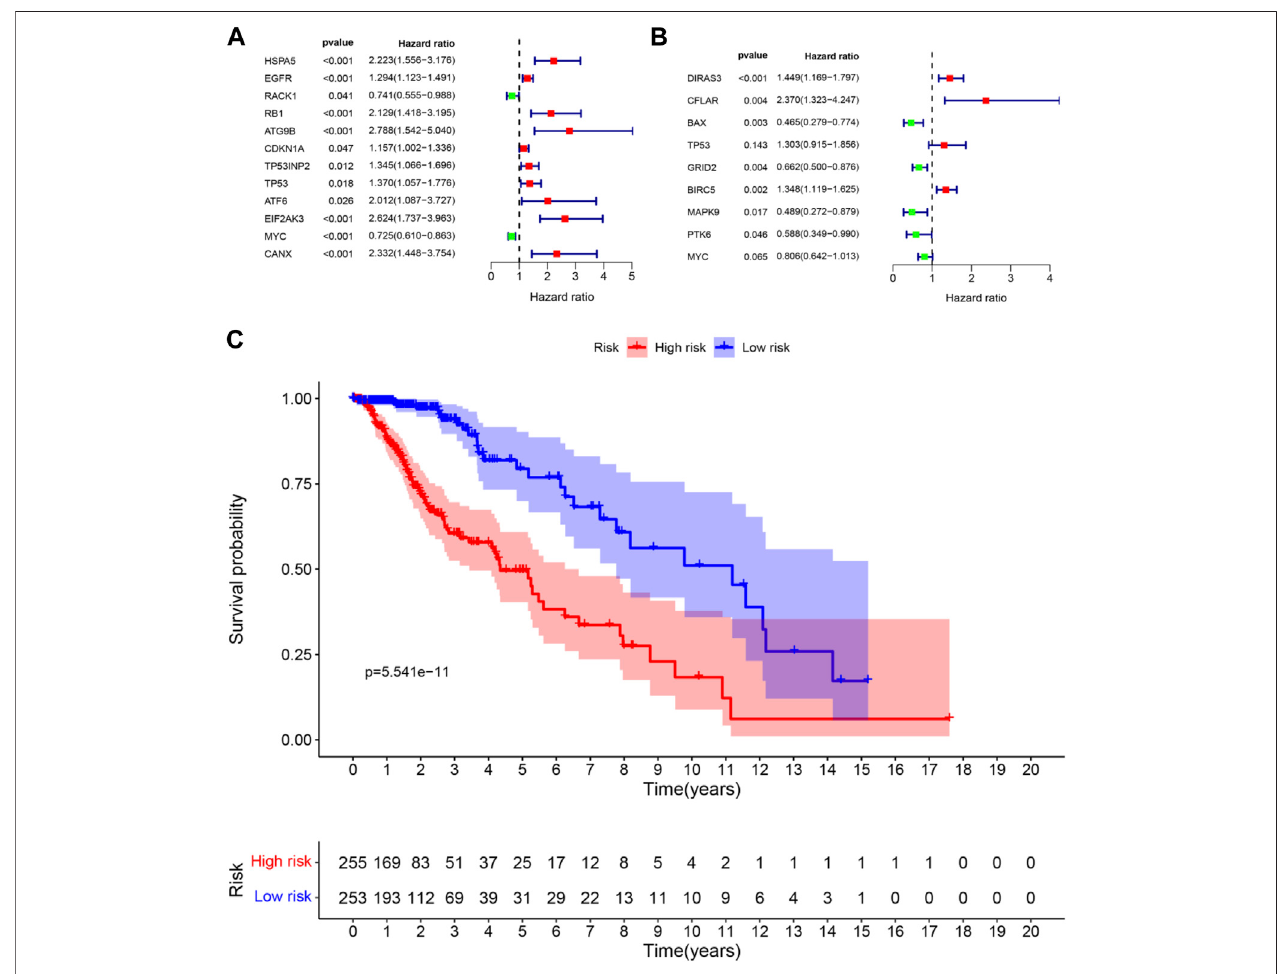
FIGURE 3 | Forest plots and Kaplan – Meier curve (A) forest plot of univariate Cox regression for 12 prognosis-related DE-ARGs; (B) forest plot of multivariate Cox regressionfor9sortedprognosis-relatedDE-ARGs; (C) Kaplan – MeiercurveforLGGpatients ’ OSinthehigh-riskandlow-riskgroupswhenstrati fi edbytheautophagy- relatedriskscore(FDRcorrectionhad beenused fordifferentialgeneticscreening, and p -valuesinCoxregressionwereprovided bythewald χ 2 test, and nofurtherFDR correction is required.)